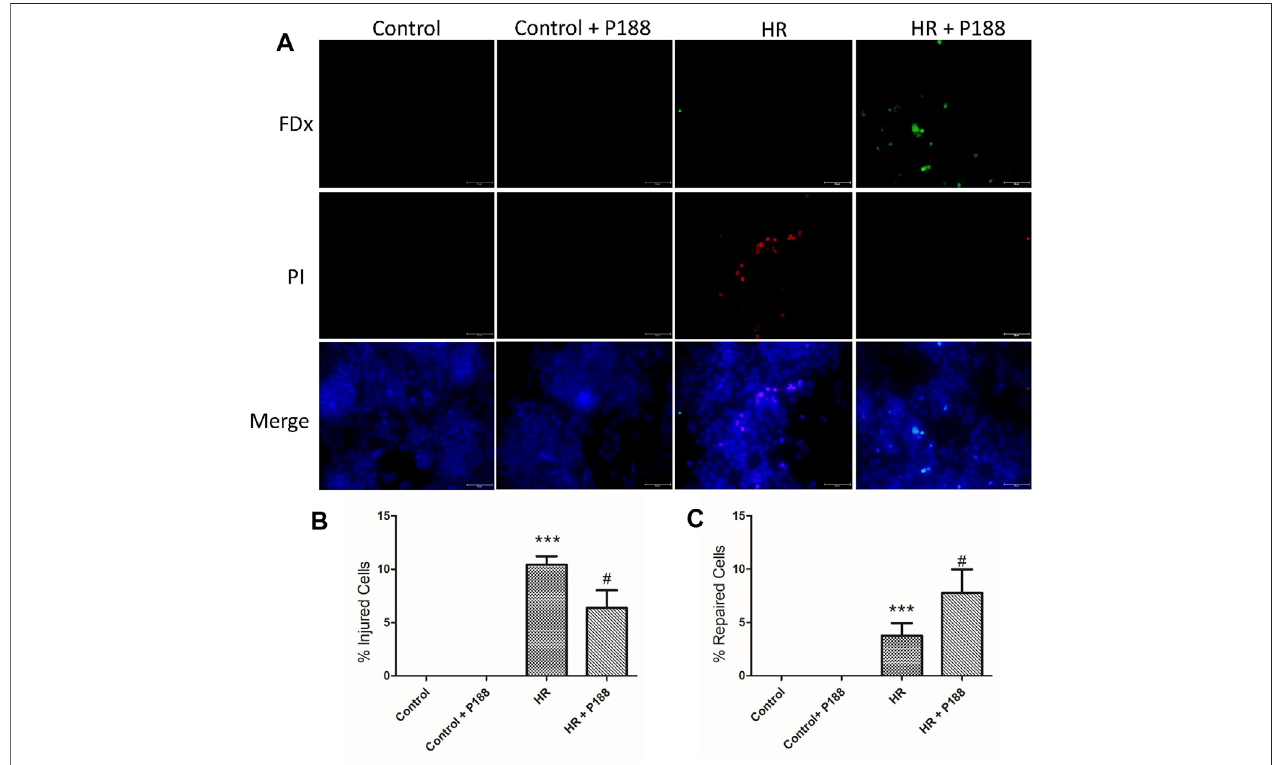
FIGURE9|(A) P188enhancescellmembranerepairafterhypoxia/reoxygenation(HR)injuryinMLE-12cells.Representative fl uorescenceimagesofcellsexposed to HR in the presence or absence of P188. Cells with green cytoplasmic dextran (FDx) fl uorescence were considered wounded but healed, whereas cells with red propidium iodide (PI) fl uorescent nuclei were considered wounded but permanently injured. Images were merged with DAPI nuclear counterstain (blue). (B) Percentage of injured cells per fi eld. (C) Percentage of repaired cells per fi eld. Scale bar shows 100 μ m. Data are mean ± SD ( n (cid:2) 6 plates). *** p < 0.001 compared with the control group; # p < 0.05 compared with the HR